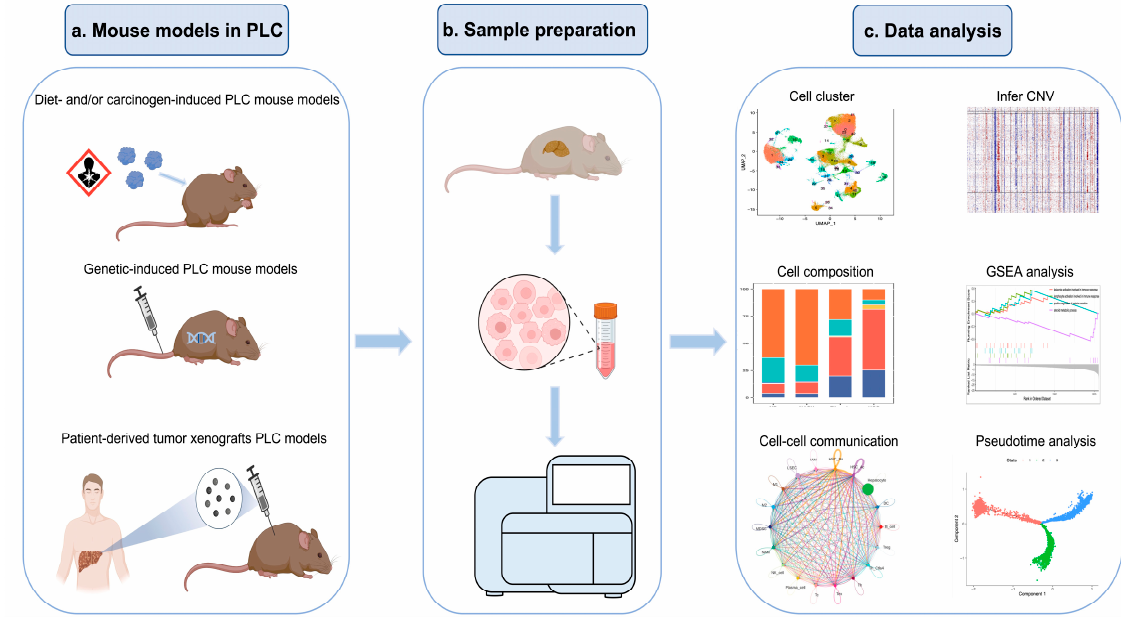
Figure 1. Overview of the workflow of scRNA-seq analysis of PLC in mouse models.